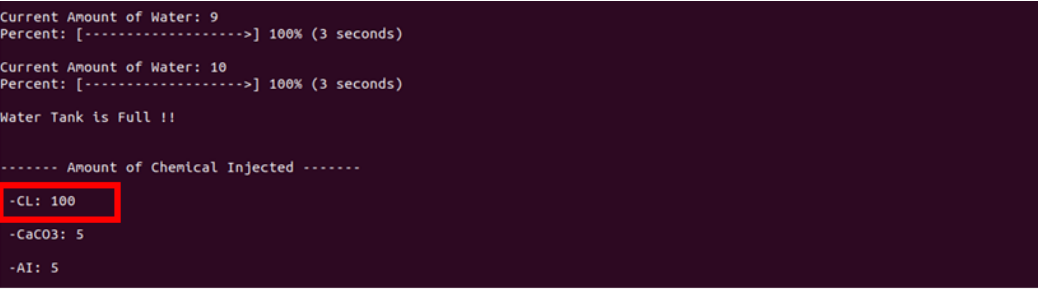
Figure 15. Screen manipulated by a rogue client.